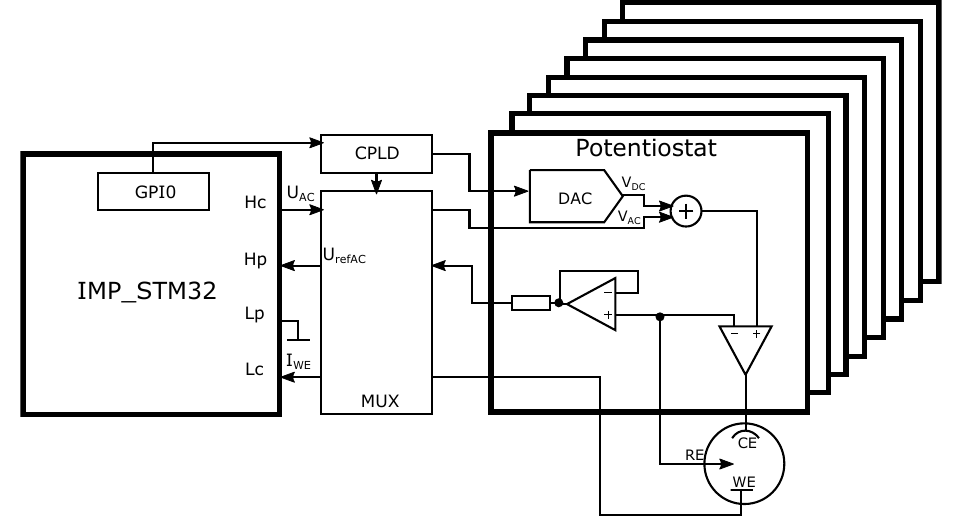
Figure 3. Schematic of eight-channel, compact, digitally controlled potentiostat dedicated for impedance analyzer